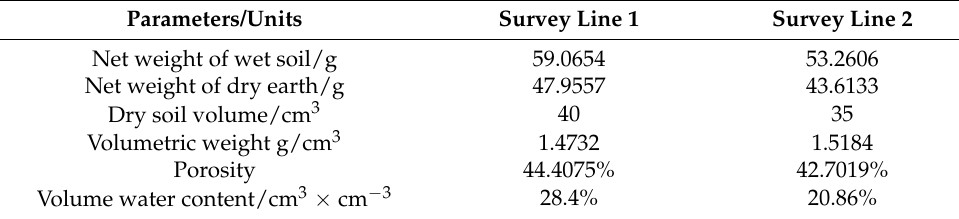
Table 3. Detailed information about field soil samples.